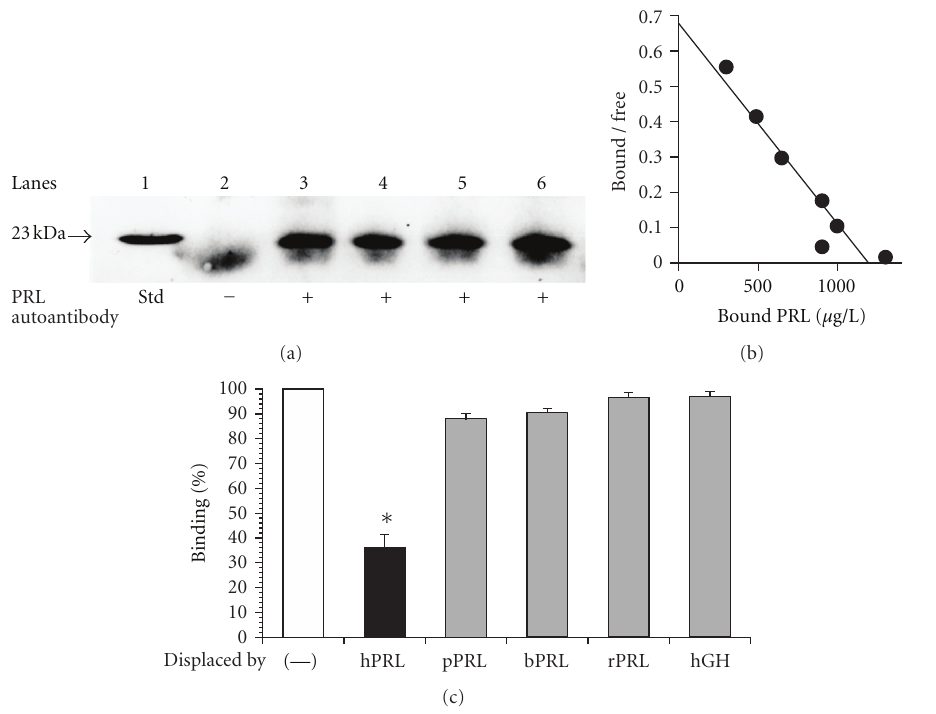
Figure 4: Electrophoresis of macroprolactin and Scatchard analysis of anti-PRL autoantibodies. (a) IgG was purified from the sera of the patients with macroprolactinemia (lanes 3–6) using a protein G column and run on SDS-PAGE under a nonreducing condition. PRL, which bound to the autoantibodies, was dissociated and immunostained at the same position as the 23 kDa human PRL standard (lane 1). The 23kDa PRL band was not observed when IgG from a patient with prolactinoma was used (lane 2). The fuzzy bands migrating faster than PRL may be nonspecific staining of IgG light chain. (b) Scatchard analysis revealed low-a ffi nity and high-capacity autoantibodies. (c) Displacement of 125 I-hPRL-autoantibody complex by human PRL and other related peptides; hPRL: human PRL, pPRL: porcine PRL, bPRL: bovine PRL, rPRL:r at PRL, and hGH: human GH. Only hPRL could displace the binding of 125 I-PRL with the autoantibodies. (Reproduced from [5, 15,